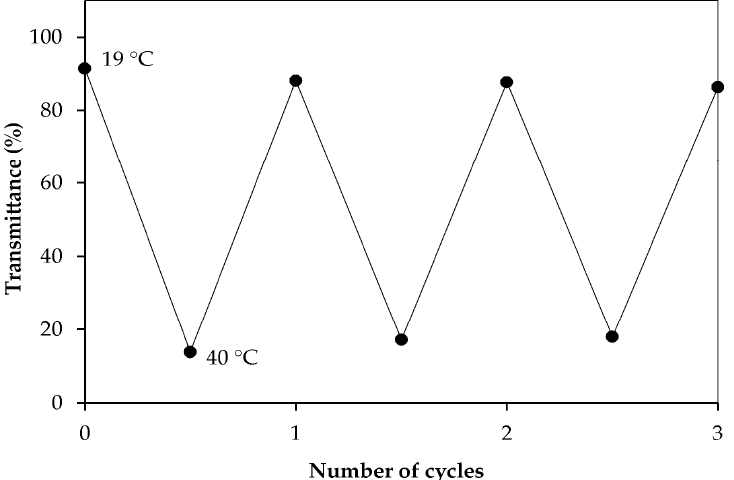
Figure 12. Transmittance cycling of the PNVCL- b -PCL (1) block copolymer micelle solution (0.5 mg mL − 1 ) between 19 and 40 °C.